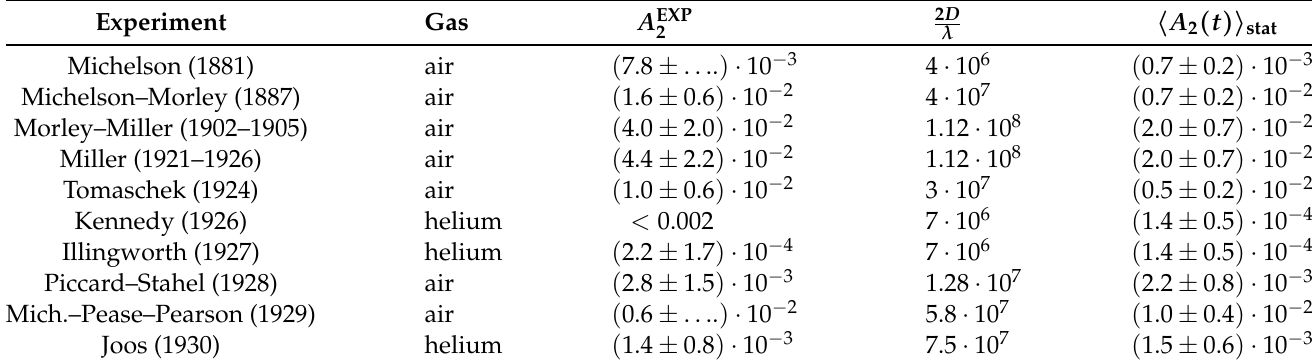
Table 2. The average second-harmonic amplitudes of classical ether-drift experiments. These were extracted from the original papers by averaging the amplitudes of the individual observations and assuming the direction of the local drift to be completely random (i.e., no vector averaging of different sessions). These experimental values were then compared with the full statistical average in Equation (46) for a projection of the velocity of 250 km/s ≤ ˜ v ( t ) ≤ 370 km/s and refractivities of (cid:101) = 2.8 · 10 − 4 for air and (cid:101) = 3.3 · 10 − 5 for gaseous helium. The experimental value for the Morley–Miller experiment was taken from the observed velocities reported in Miller’s Figure 4 and, here, our Figure 3. The experimental value for the Michelson–Pease–Pearson experiment refers to the only known session for which the fringe shifts were reported explicitly [34] and where the optical path was still fifty-five feet. The symbol ± . . .. means that the experimental uncertainty cannot be determined from the available